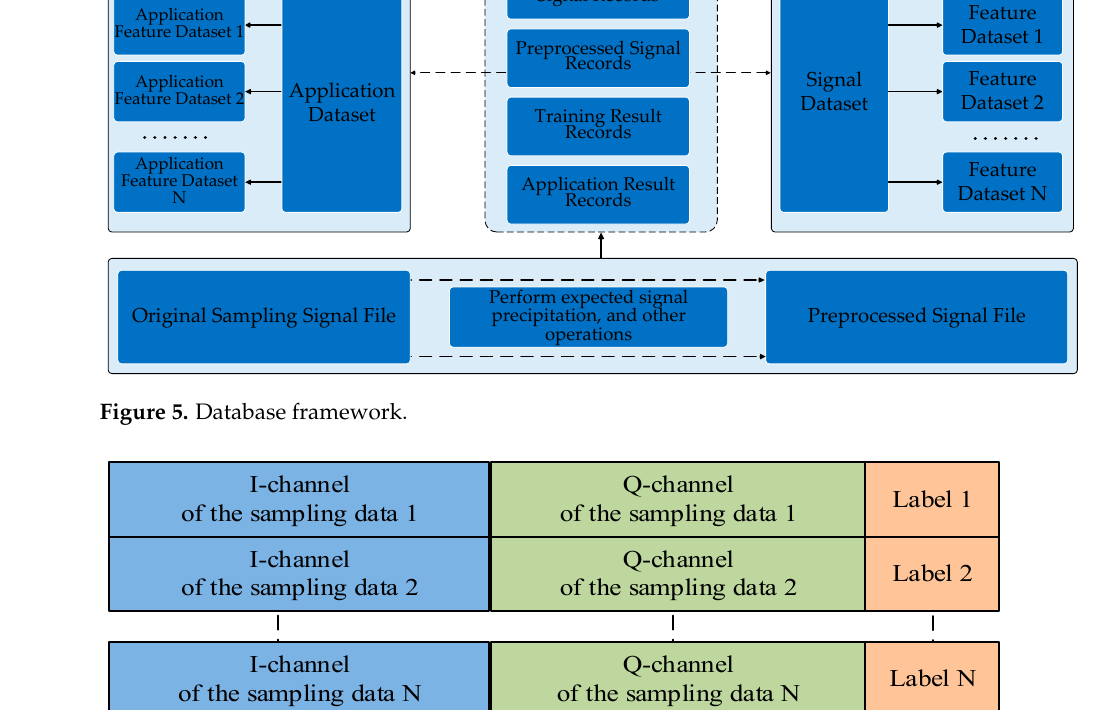
Figure 6. Dataset structure.